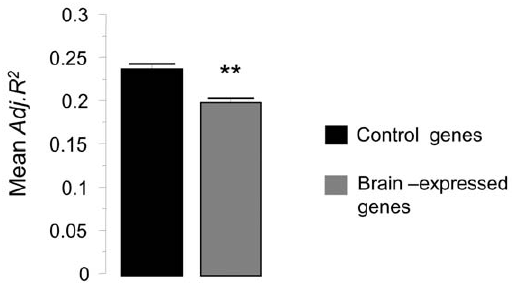
Figure 3. AA usage and encephalization correlation is not restricted to brain-expressed genes. We compiled 12456 sets of orthologous genes encompassing all 37 species, and each set containing at least 20 orthologs. For each sets, we obtained the multiple regression coefficients ( Adj. R 2 ) between AA frequencies (per gene per individual set of orthologs) and Ei values of all 37 species using the same predictors of Table. We then obtained human tissue expression data from BodyMap database for 18 tissues with known expression in over 50% of all human genes also present in our database. We identified 10647 brain-expressed genes and 1594 genes with known expression specifically outside the brain (control genes). Bars in the graph compare the mean Adj. R 2 value of these control genes ( 6 SEM) with the corresponding mean value of brain-expressed genes. Confidence interval for brain-expressed genes, was estimated using100 equally sized random samples. ** P , 0.0001.